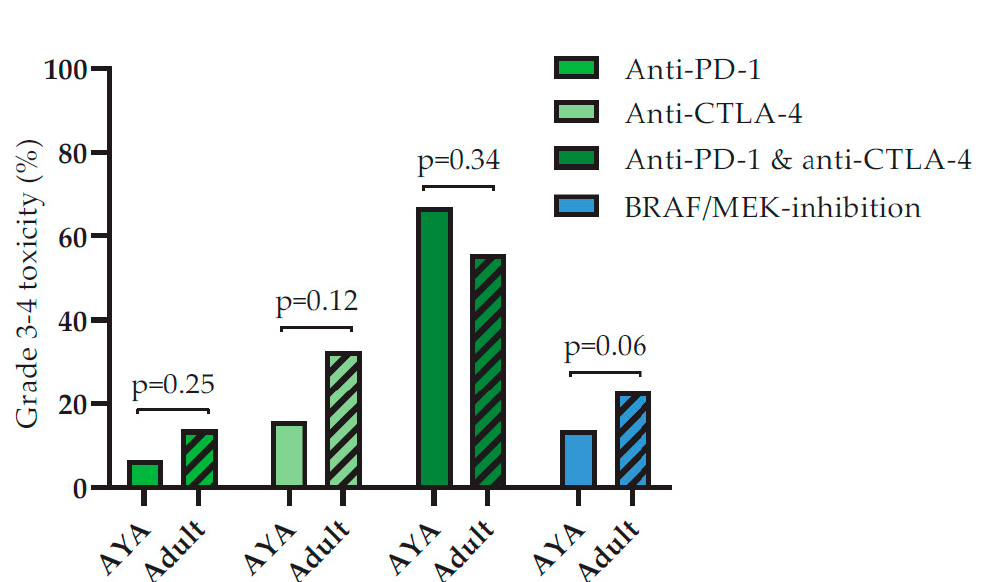
Figure 4. Toxicity rates following initial treatment for advanced melanoma of both Adolescents and Young Adults (AYAs) and older adults (Adult).